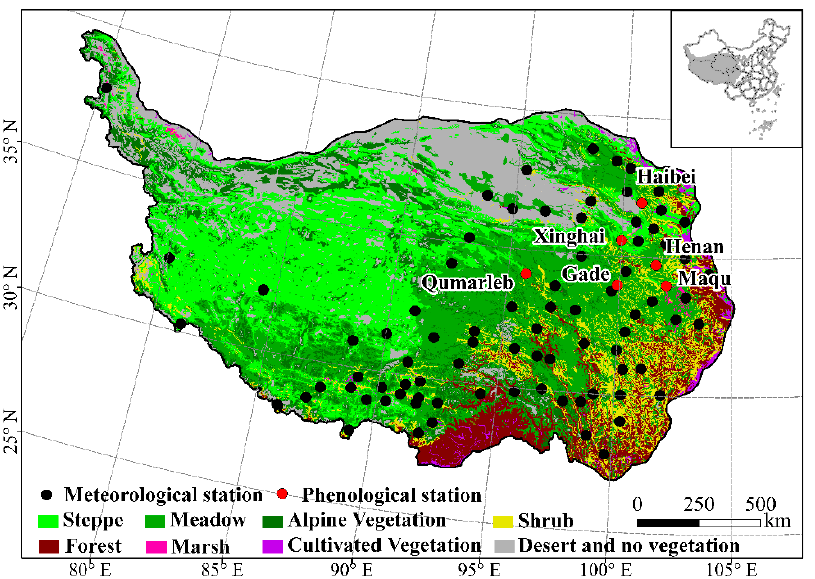
Figure 1. Spatial distribution of vegetation type and meteorological and phenological stations on the QTP.